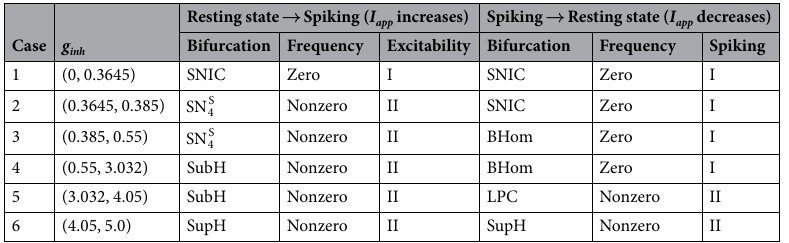
Table 2. Six cases of bifurcations corresponding to excitability/spiking classes induced by inhibitory